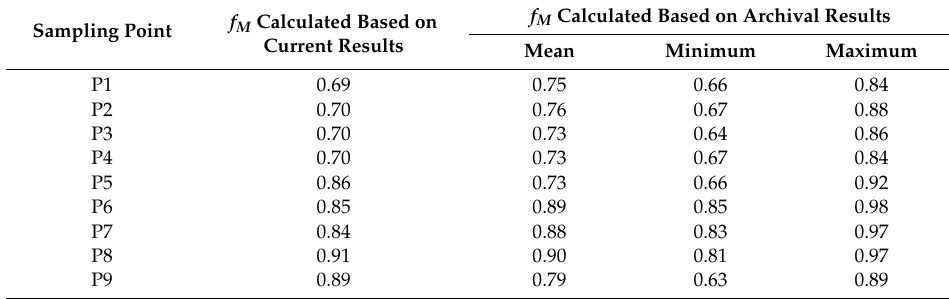
Table 3. Values of f M empirical